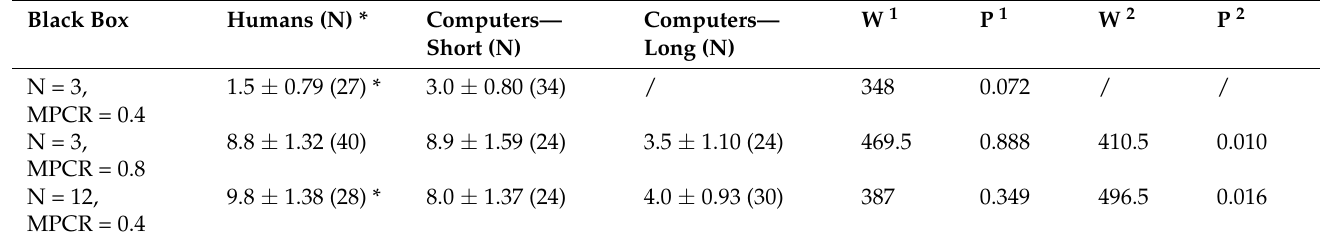
Table 3. Beliefs about the best number. The mean ± SE value participants stated as the best number to input at the end of the game. Comparisons made with Wilcoxon rank-sum test.